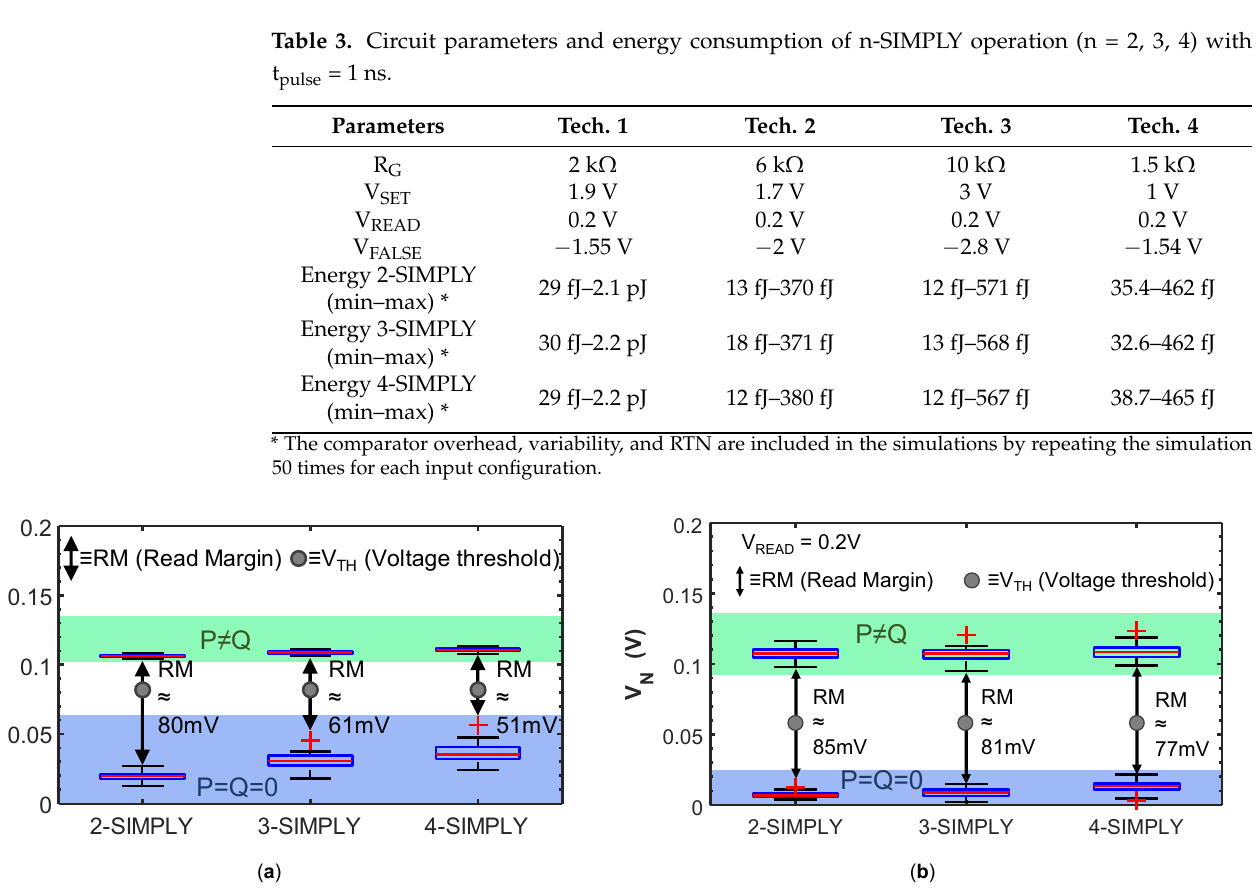
Figure 7. Distribution of the V N voltage ( a ) experimentally evaluated with technology 4, and ( b ) simulated with the compact model calibrated on technology 3, for increasing number of input bits (i.e., n = 2, 3, 4), including variability (50 trials) when P = Q = 0 (blue bands) and P ≠ Q (green bands) for the n -SIMPLY operation ( n = 2,3,4) at V READ = 0.2 V. The read margins (RM—black arrows) and associated threshold voltages (V TH —grey circle) for the comparator are evidenced. Black whiskers indicate the extreme points of the distributions. Red crosses indicate outliers due to RTN. V N when P = Q = 1 is always much higher than in all other cases (thus is not reported in these box plots). Table 3. Circuit parameters and energy consumption of n-SIMPLY operation (n = 2,3,4) with t pulse = 1 ns.